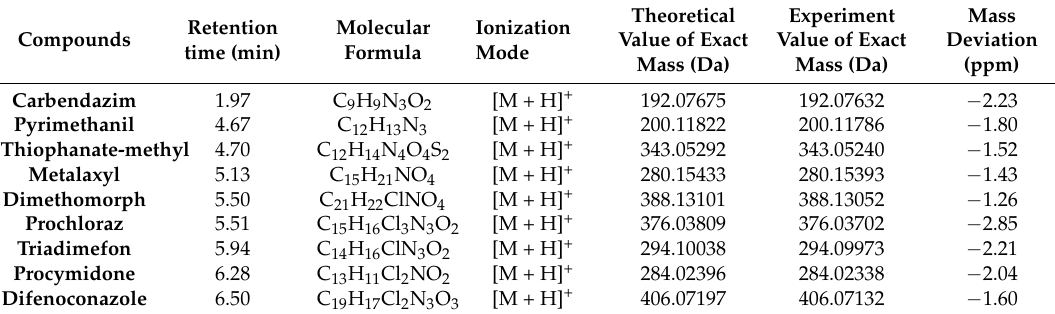
Table 1. The molecular formula, exact mass, mass deviation, and retention time of nine target fungicides. Retention Molecular Compounds time (min)